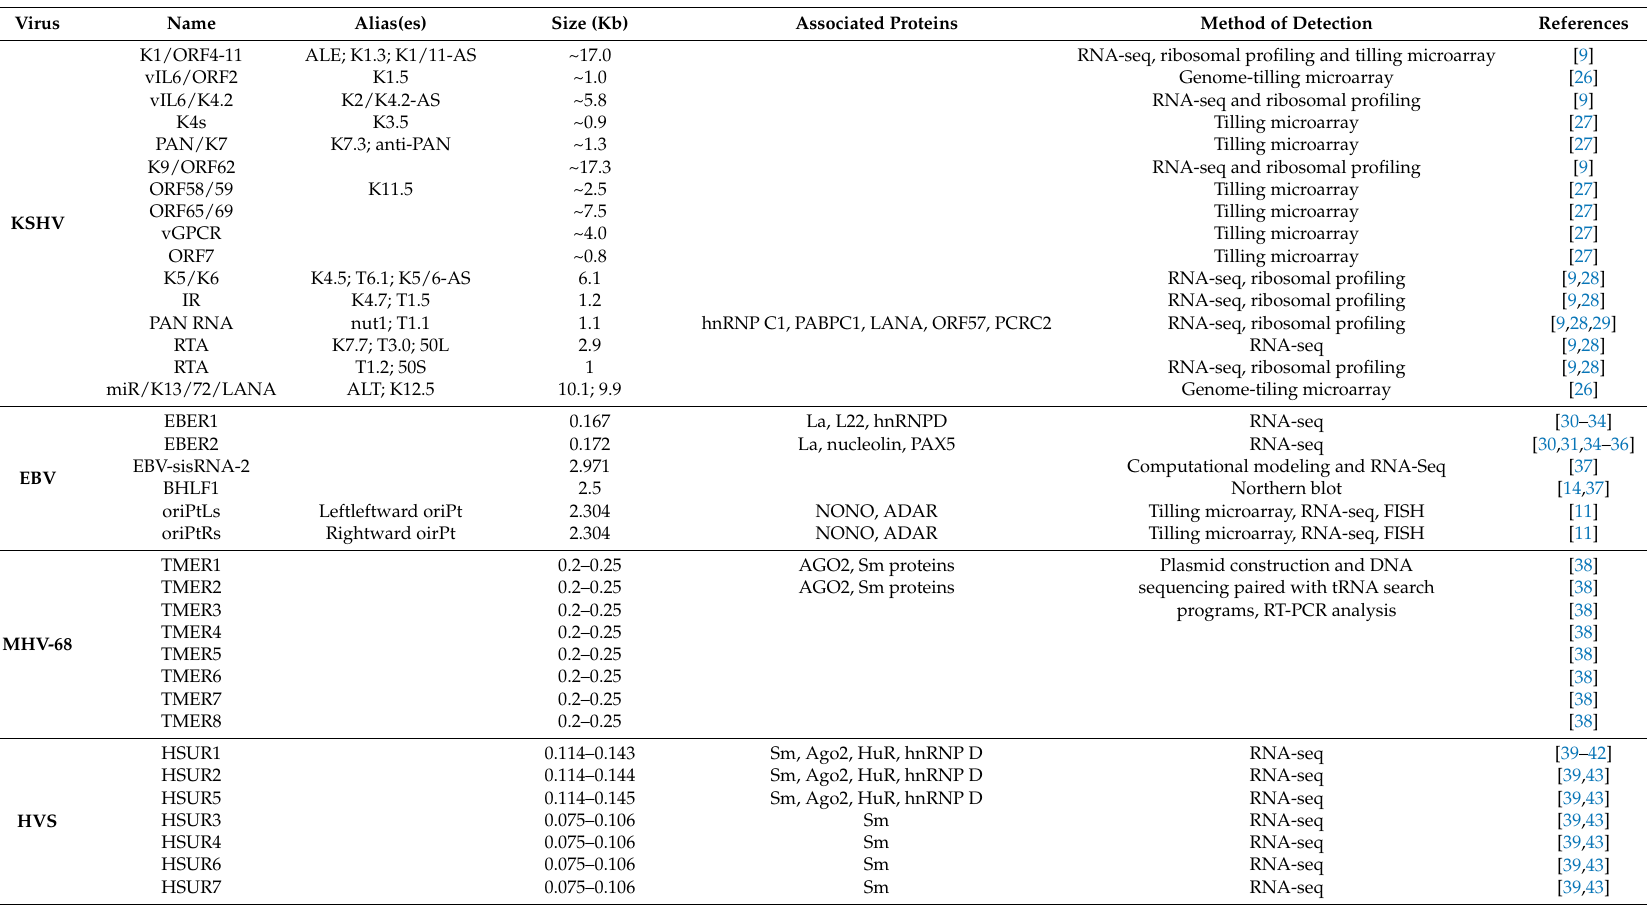
Table 1. Long non-coding RNAs (lncRNAs) in gammaherpesvirus. The table includes: aliases ascribed to the aforementioned lncRNAs, the molecular size expressed in kilobases, proteins associated with lncRNAs, the detection method and the original